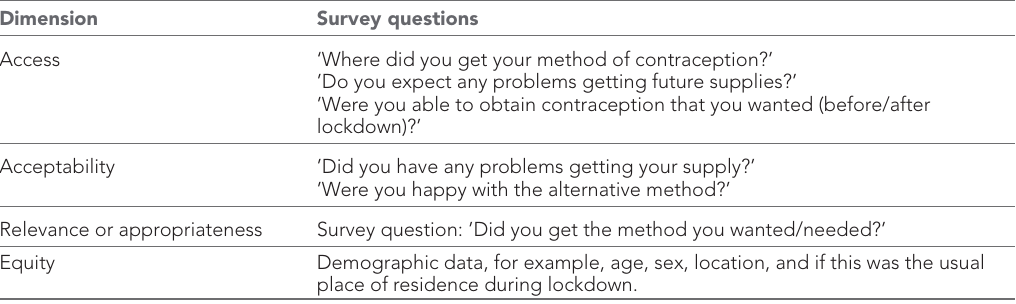
Table 1 Maxwell’s evaluation dimensions and related sources of data from survey